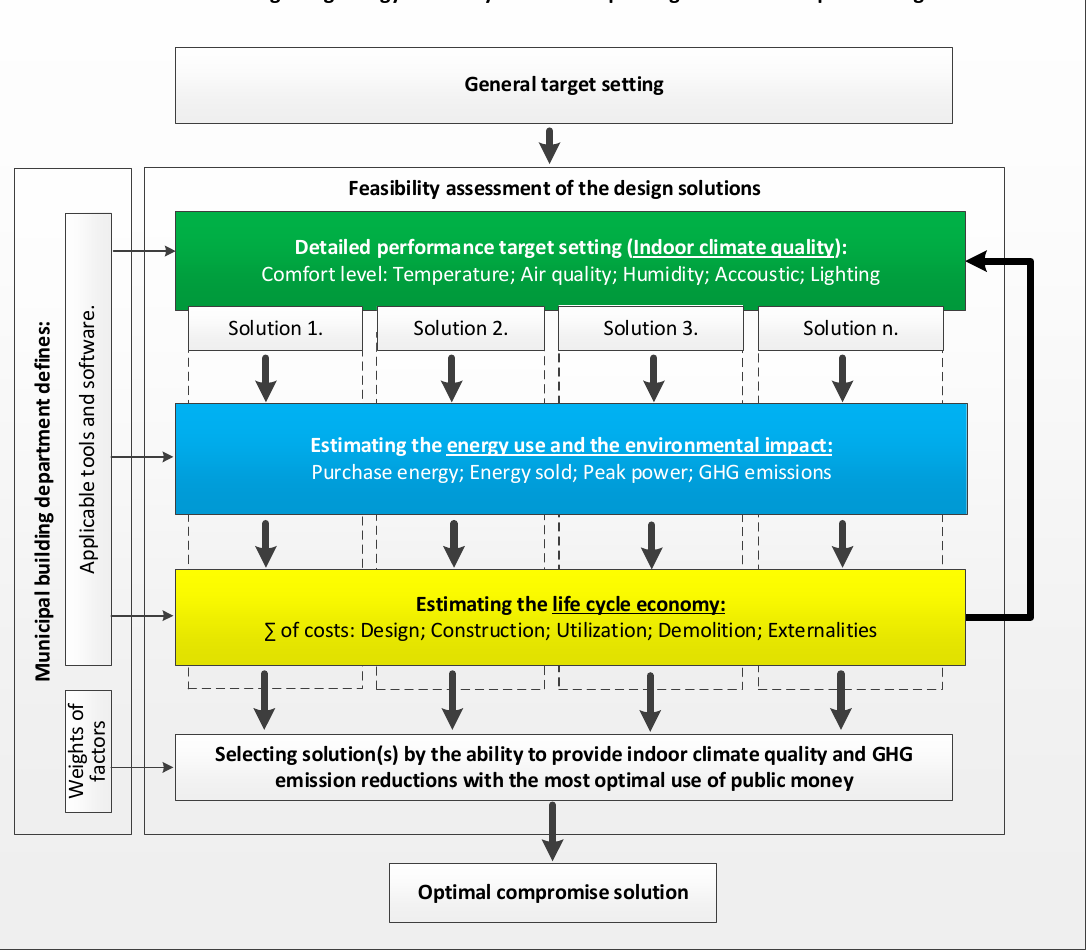
Figure 7. The identification of the optimal compromise design solution during the concept design.